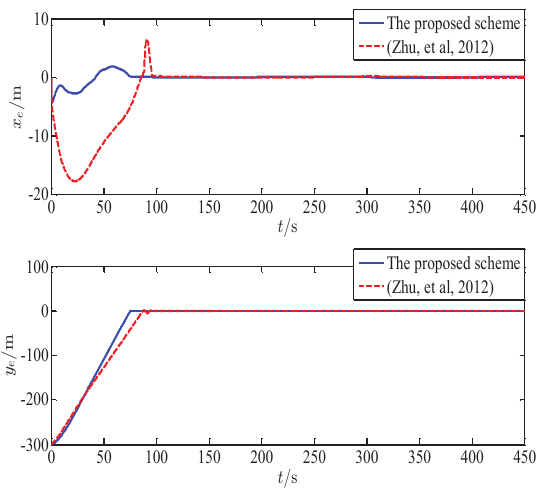
Figure 4. Position tracking results of circular trajectory.